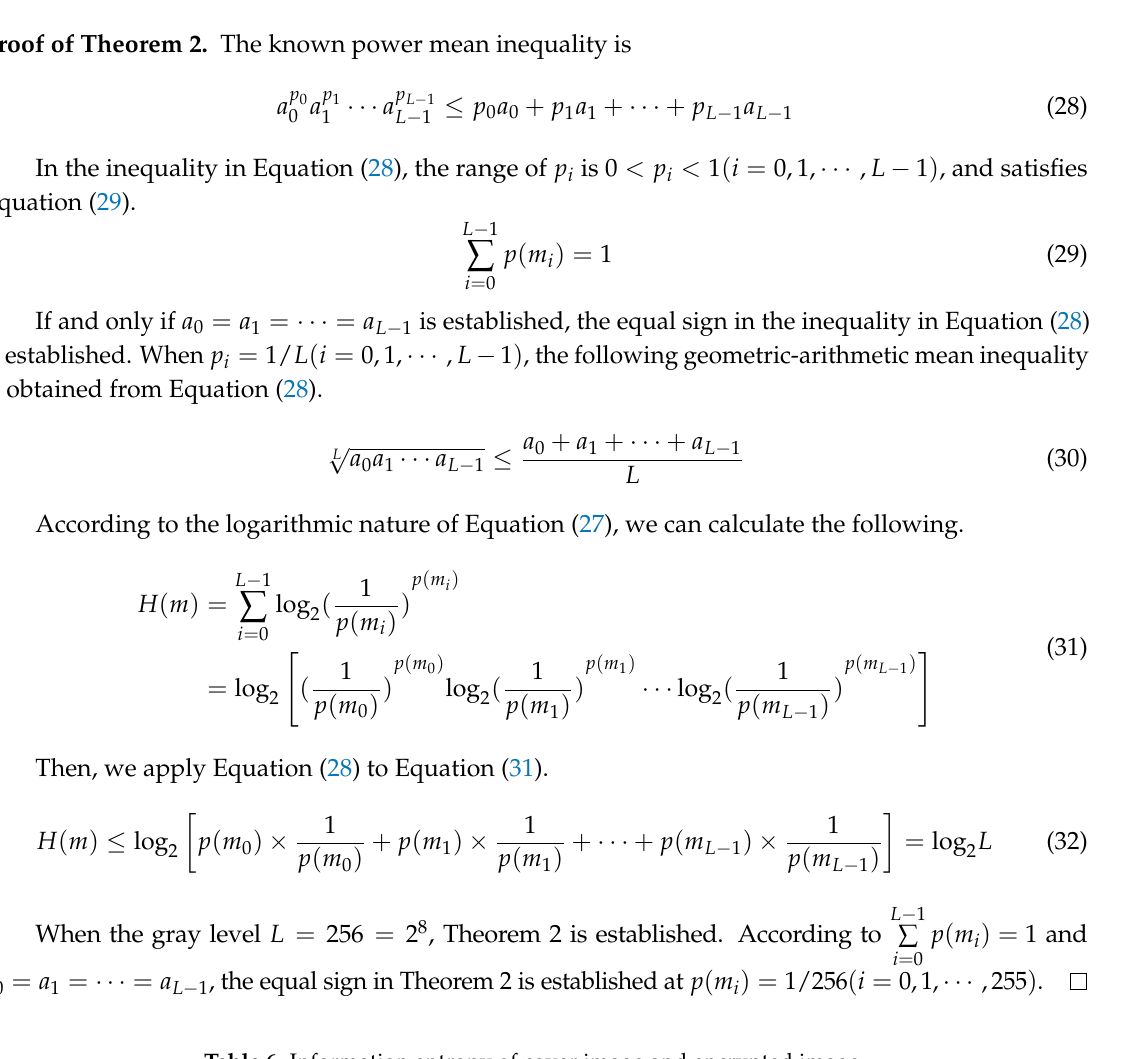
Table 6. Information entropy of cover image and encrypted